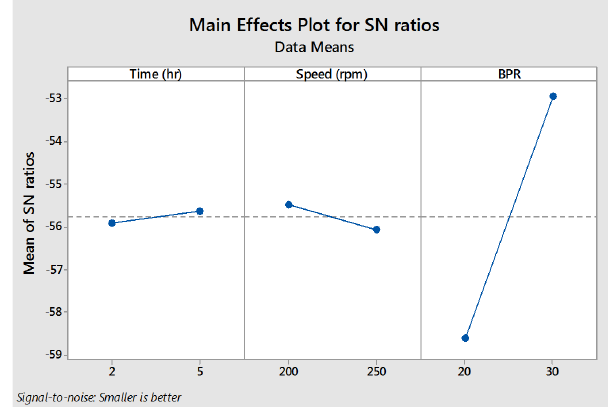
Fig. 5. The results of the average effect of the parameters under study on the average particle